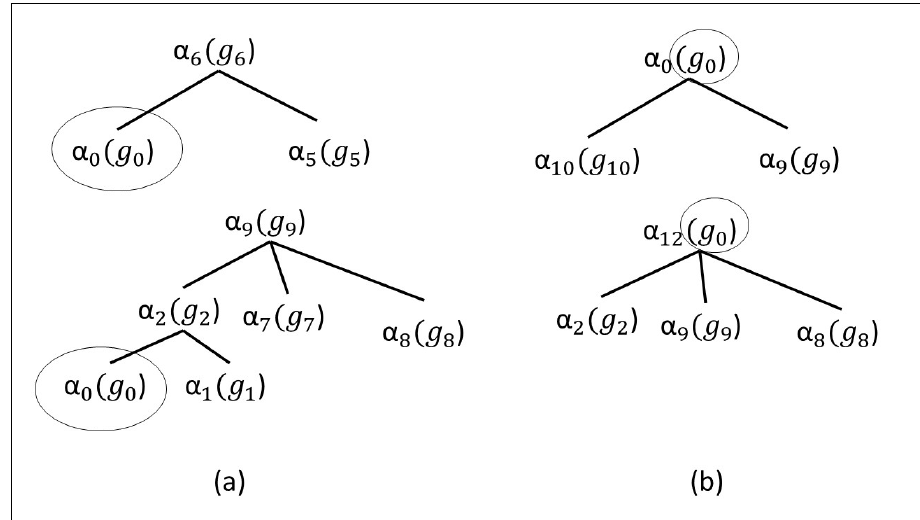
Figure 2. Example of plans in Ω R exploited by the robot in order to perform respectively over help ( a ) and critical help ( b